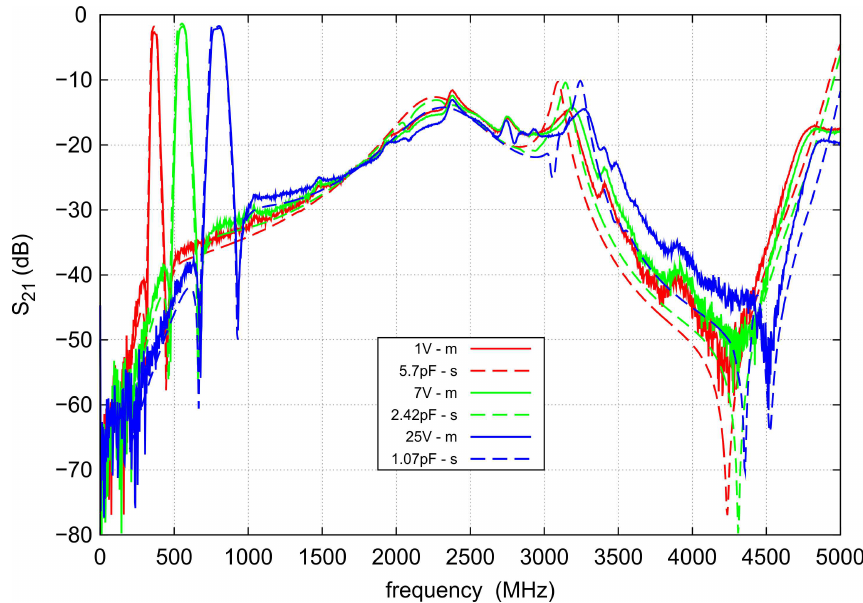
Figure 16. Broadband measurements (solid lines) and simulations (dashed lines) of the s 21 for the three selected control